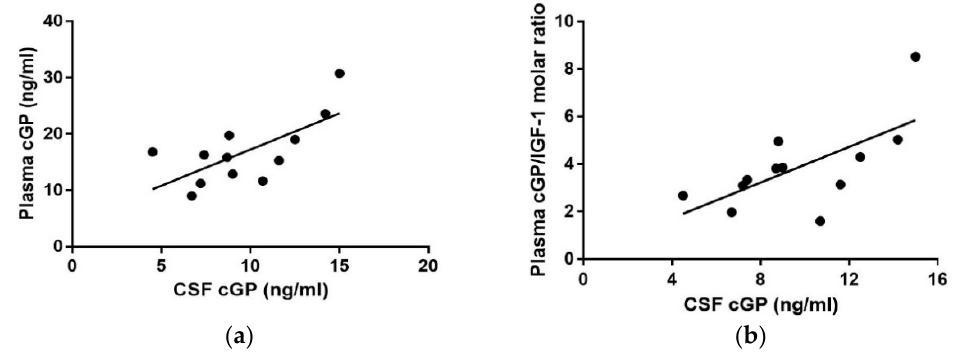
Figure 4. Correlation between the concentrations of cGP in CSF and plasma. ( a ) There was a significant positive correlation between CSF and plasma cGP (R = 0.68, p < 0.01). ( b ) There was a significant positive correlation between CSF cGP and plasma cGP/IGF-1 (R = 0.66, p < 0.01). There was no correlation in IGF-1 concentration between the CSF and plasma (R = − 0.10, p = 0.75) and no correlation between cGP and IGF-1 concentration in both CSF (R = − 0.13, p = 0.69) and plasma (R = 0.05, p =